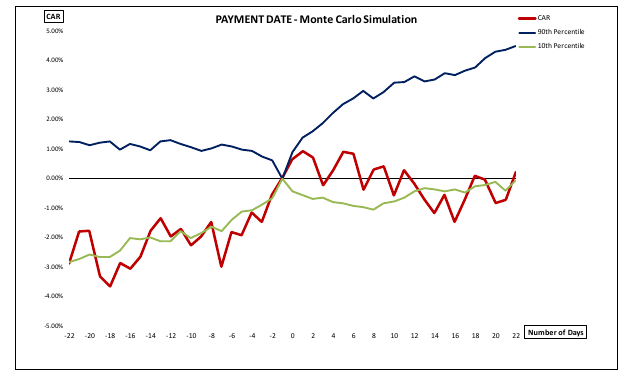
Figure 6: Monte Carlo simulation results of cumulative abnormal returns for the payment event window Buy and hold portfolio